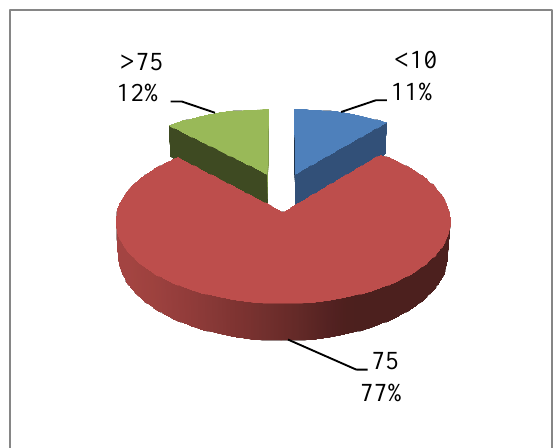
Fig. 1. Characterization of proteins by molecular